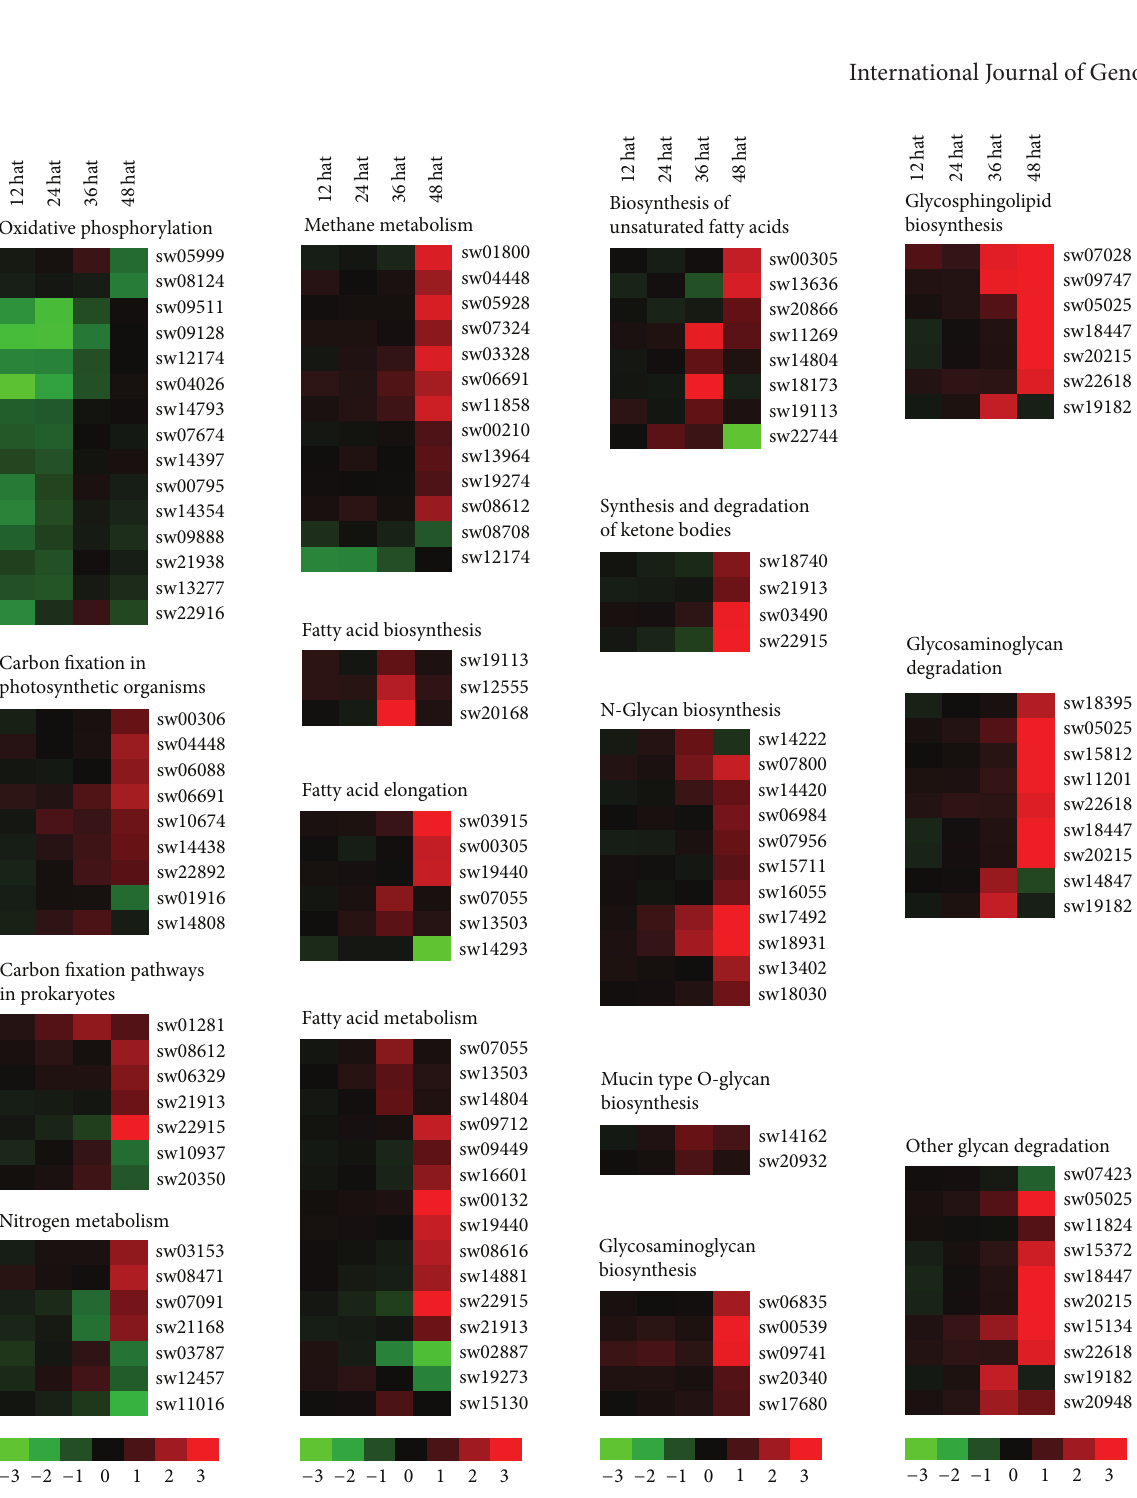
Figure 4: JHA-modulated pathways related to the metabolism of energy, lipids, or glycans. Cluster analysis of JHA-modulated genes involved in five pathways related to energy metabolism, five pathways related to lipid metabolism, and six pathways related to glycan metabolism. The probe ID, KEGG ID, and expression intensity of each JHA-modulated gene are listed in Tables S5 and S8. Hat: hours after